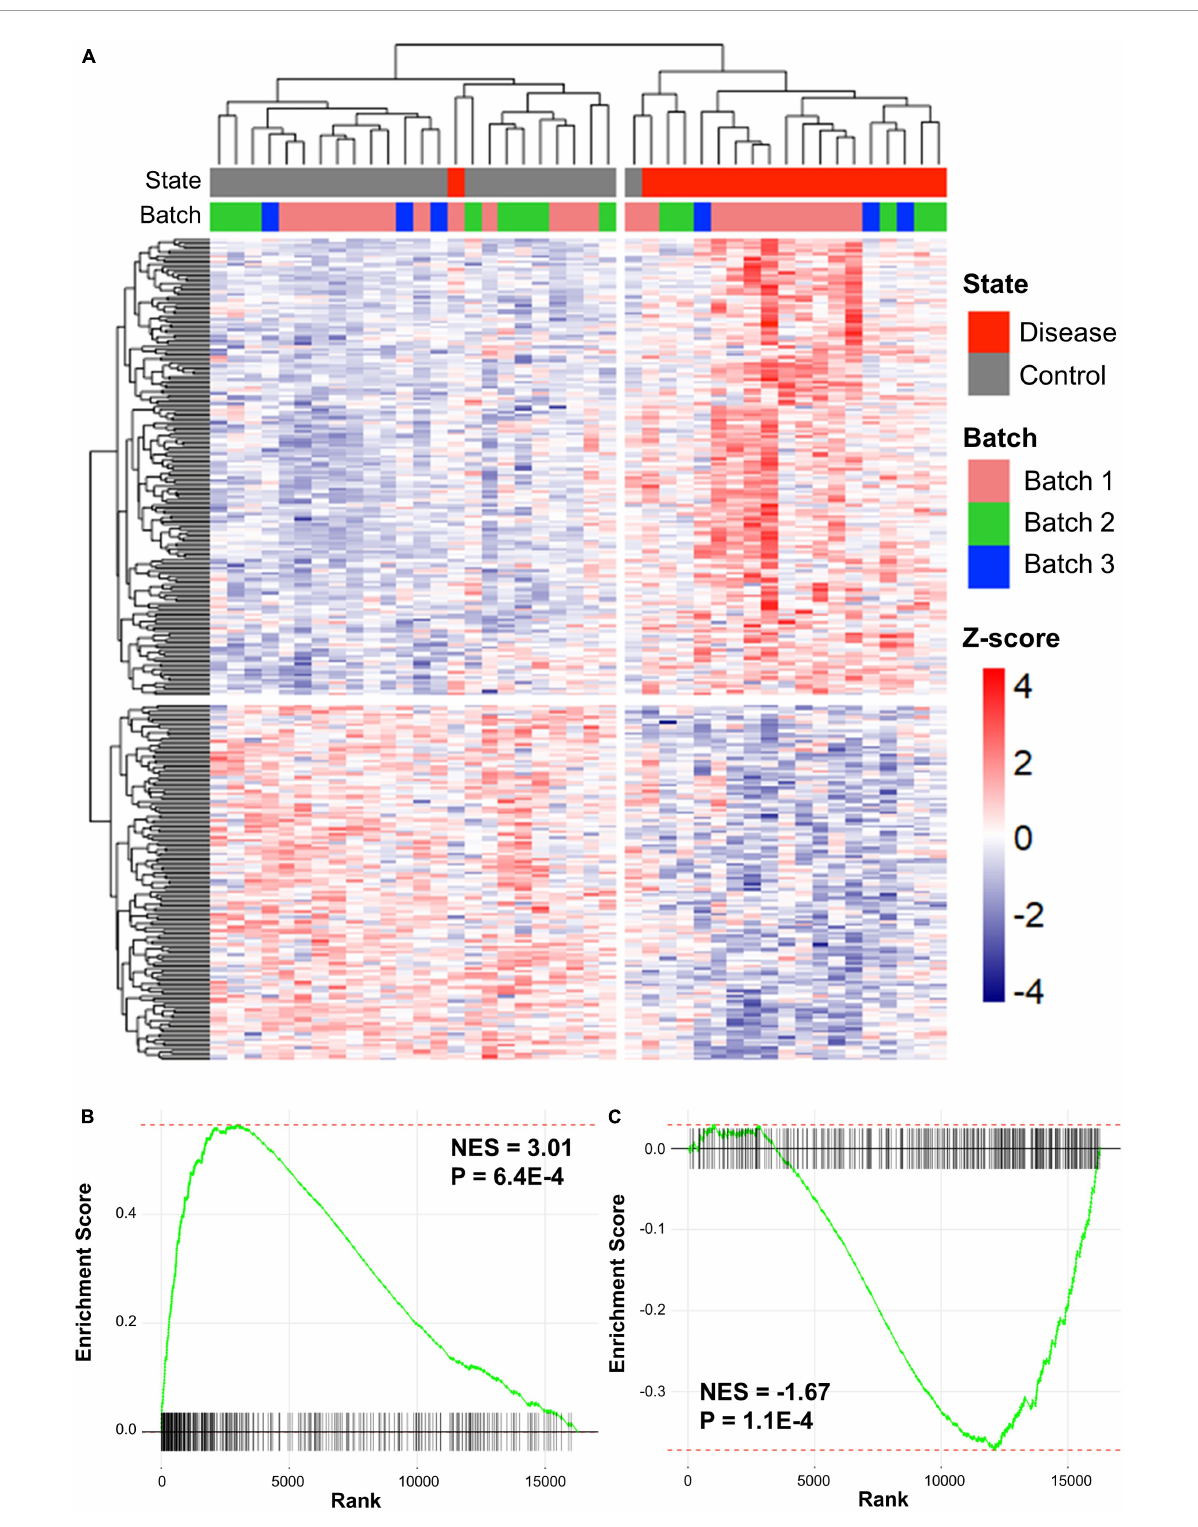
FIGURE2 Clustered results of DEGs and GSEA plots of cALD and AD. (A) Heatmap showing expression patterns of DEGs in cALD (FDR < 0.05). The disease states of individuals are shown as red and gray bars, and the batch represents the three datasets of cALD as green, blue, and pink bars above the heatmap. The color inside the heatmap shows the Z -score of cALD. GSEA plot comparing the expression of the AD dataset to DEGs that were significantly up-regulated (B) and down-regulated (C) in cALD. The normalized enrichment score (NES) indicates the degree to which DEGs of cALD were overexpressed at the top or bottom of ranked expression in the AD